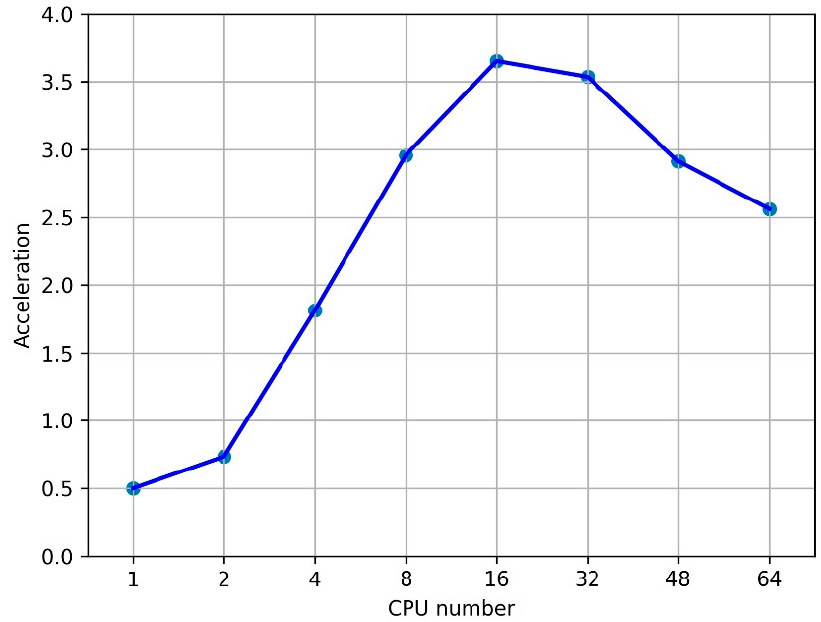
Figure 7. Dependence of acceleration on the program of the first block. The dependence of the acceleration on the program of the second block is shown in Figure 8.